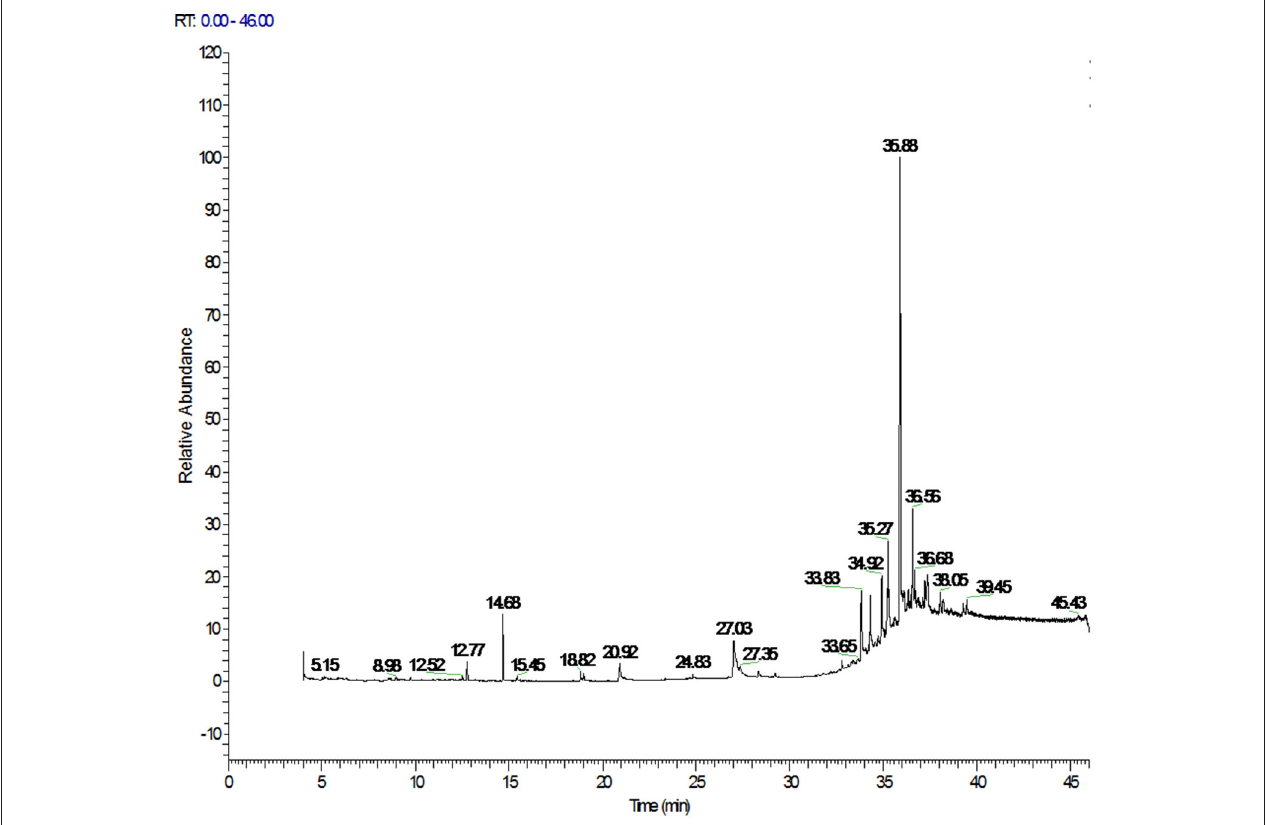
FIGURE 2 | Total ion chromatograms of PAHs in positive soybean oil